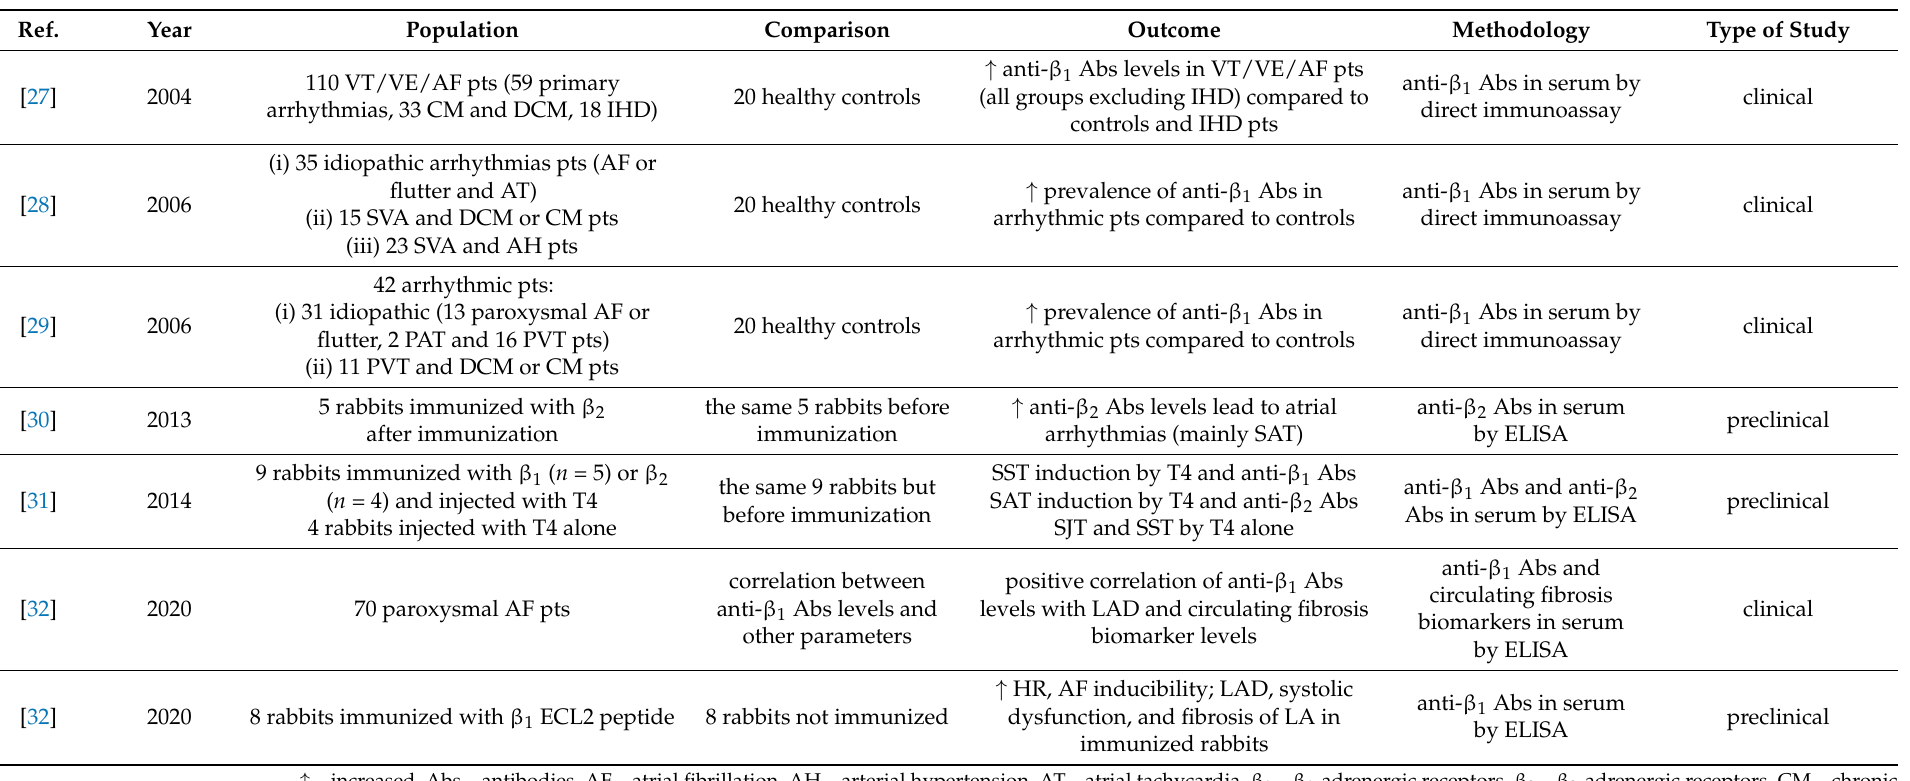
Table 1. Summary of recent research investigating only antibodies against β -adrenergic receptors.